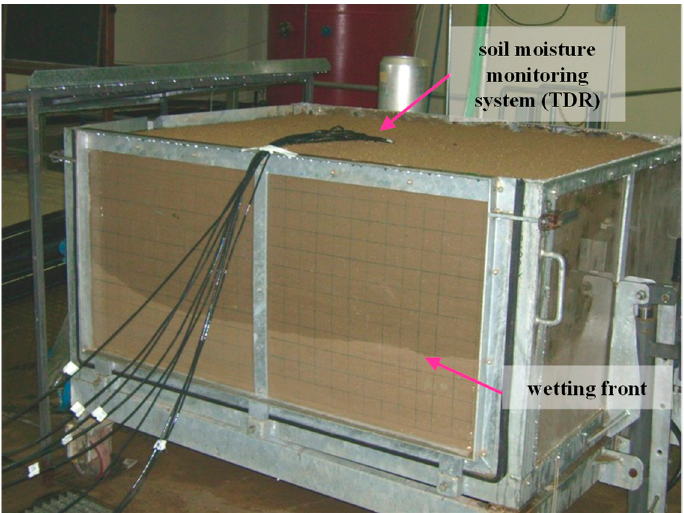
Figure 5. Laboratory experimental system adopted by References [117,118] to verify the Corradini– Melone–Smith model.